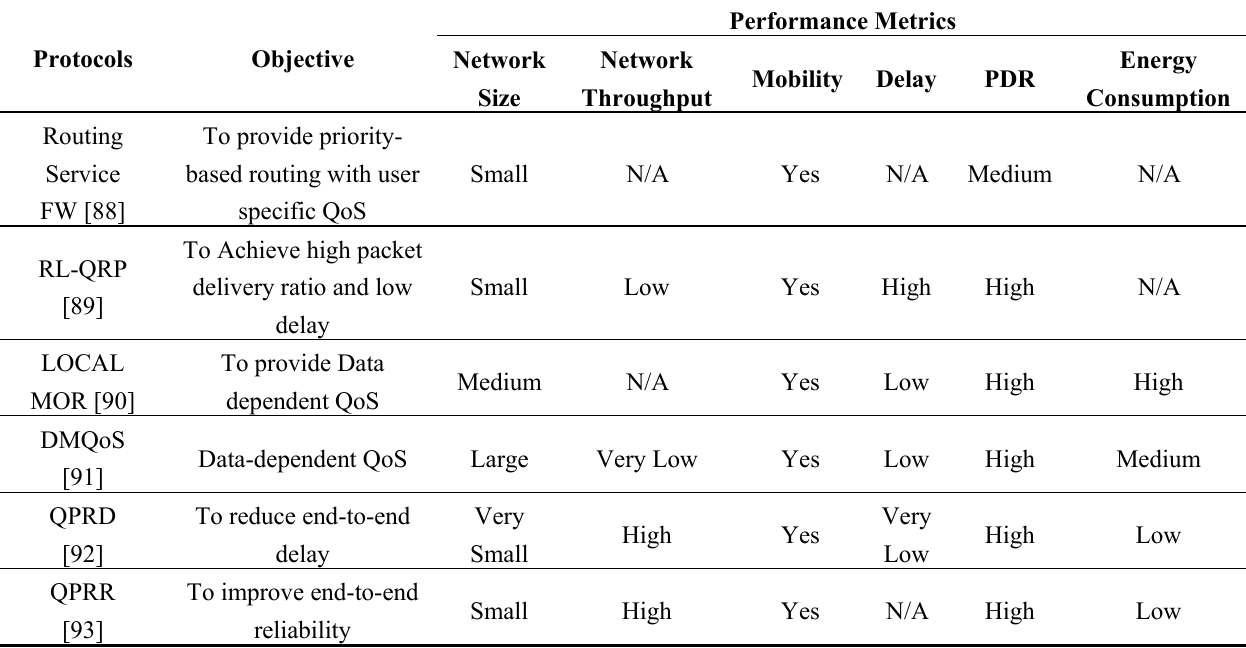
Table 11. Comparison of QoS-Aware Routing